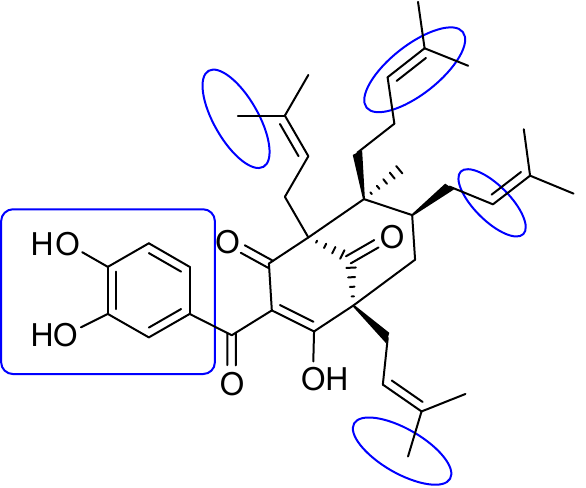
Figure 10. Pharmacophore of pose 41 or compound 2 indicating the active groups in compound 2 or pose 148.